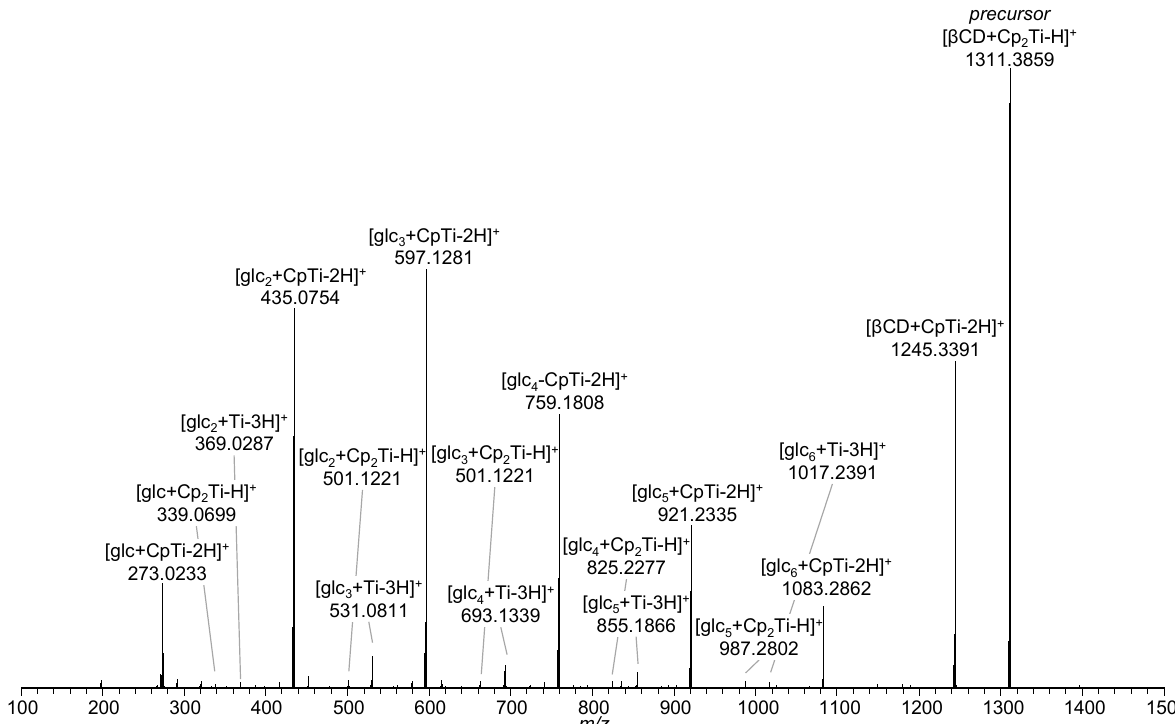
Figure 5. HCD mass spectrum of [ β CD + Cp 2 Ti–H] + ( m / z 1311.40) at 47 eV (20% NCE) showing the loss of one or two cyclopentadiene moieties (C 5 H 6 ) and the decomposition of β -cyclodextrin into its subunits, still interacting with titanocene species.